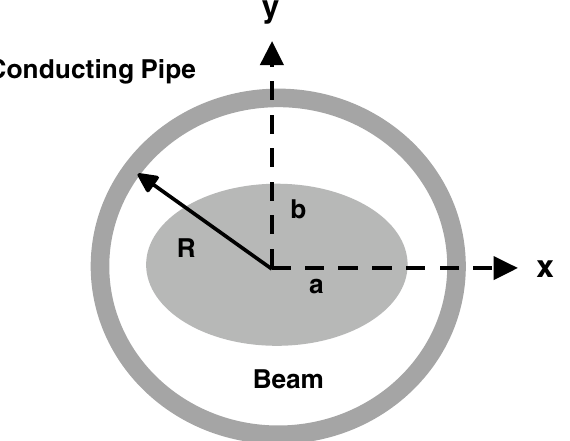
FIG. 1. Elliptical unbunched charged-particle beam in a cylindrical conducting